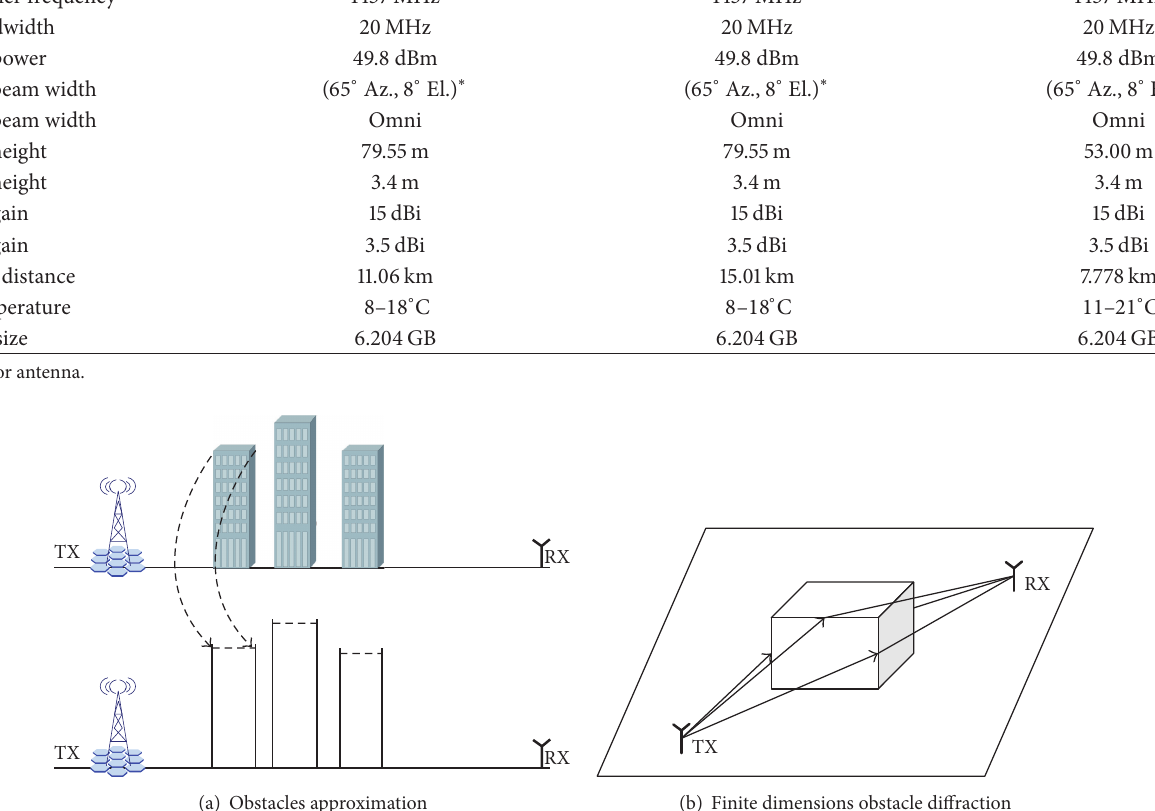
(b) Finite dimensions obstacle diffraction Figure 8: Obstacles approximation and finite dimensions obstacle